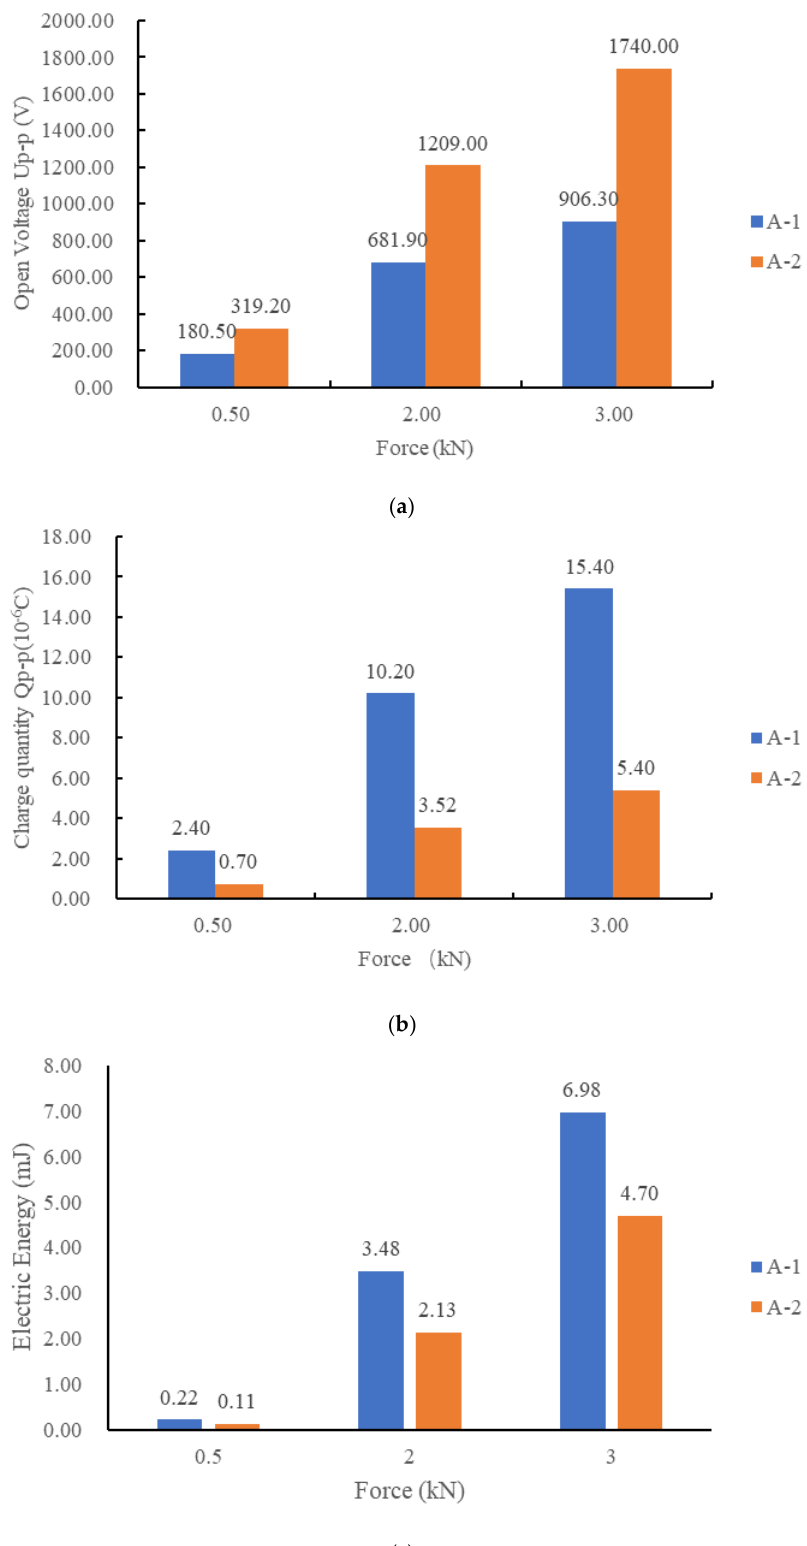
Figure 9. Comparison of electrical properties of different connection modes: ( a ) open peak–peak